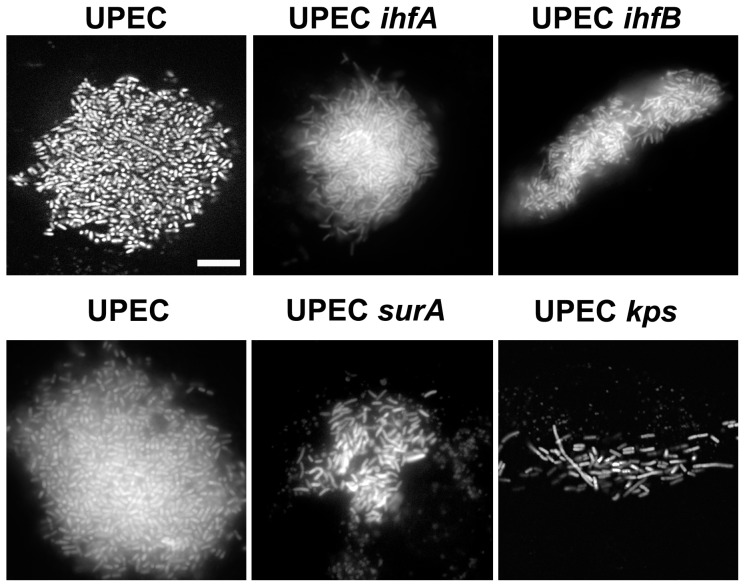
Architecture of Intracellular Bacteria.Female mice were infected with UTI89/pANT4, ROL745/pANT4 (UTI89 ihfA11), ROL603/pANT4 (UTI89 ΔihfB), SJ1000/pANT4 (UTI89 surA), or UTI89 Δkps/pANT4 for 6 hours. Bladders were prepared for visualization by fluorescent microscopy [41]. The intracellular characteristics of each of the strains indicated were visualized using strains that constitutively produce green fluorescent protein. Images were taken as an optical section (upper panel UPEC) or as total fluorescence of entire community (all other panels). The strains are indicated above each panel. Scale bar  = 10 µm and scale is unchanged between images.